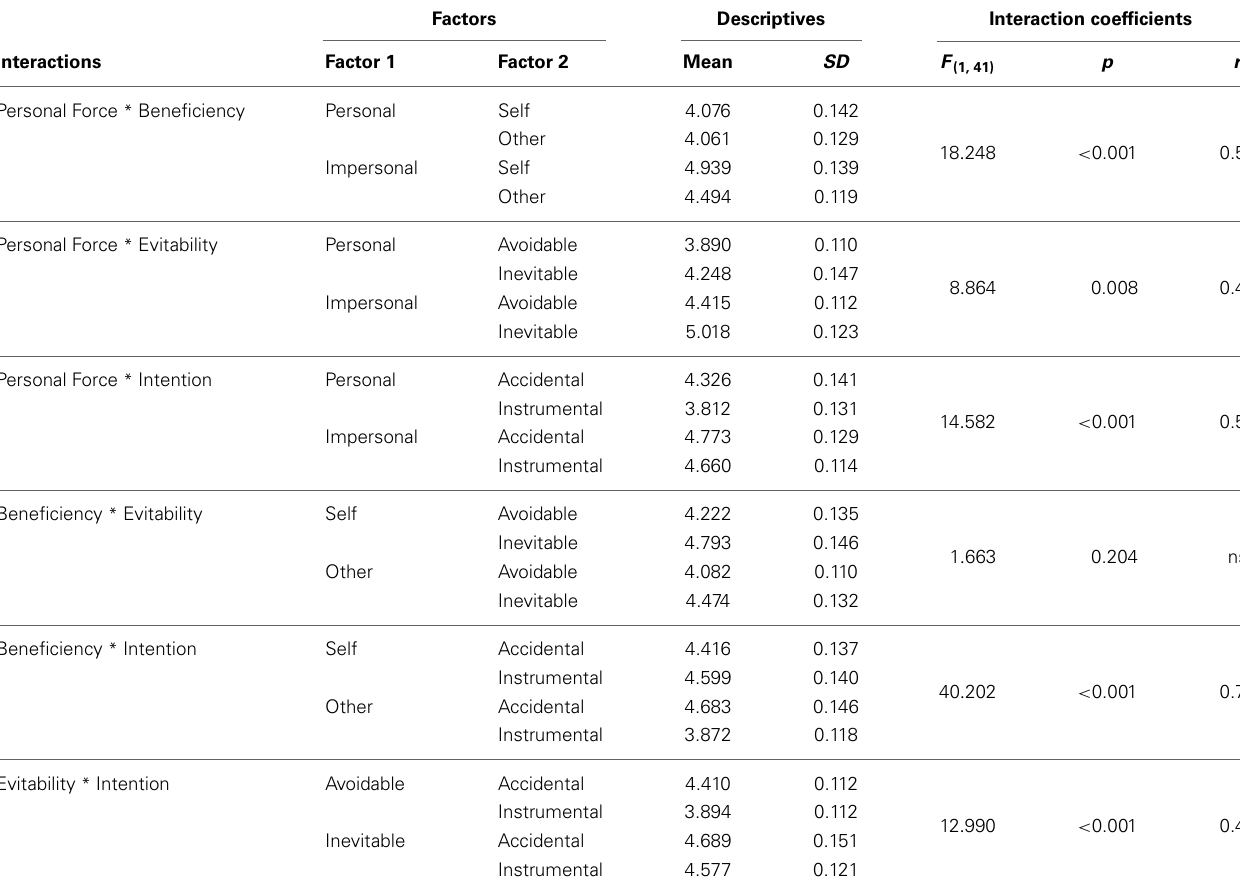
Table 6 | Summary table of the interactions (dependent variable: moral judgment, Likert scale rating; range: